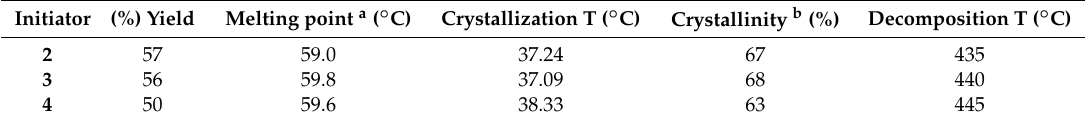
Table 4. Yield and characterization of the obtained PCL by DCS and